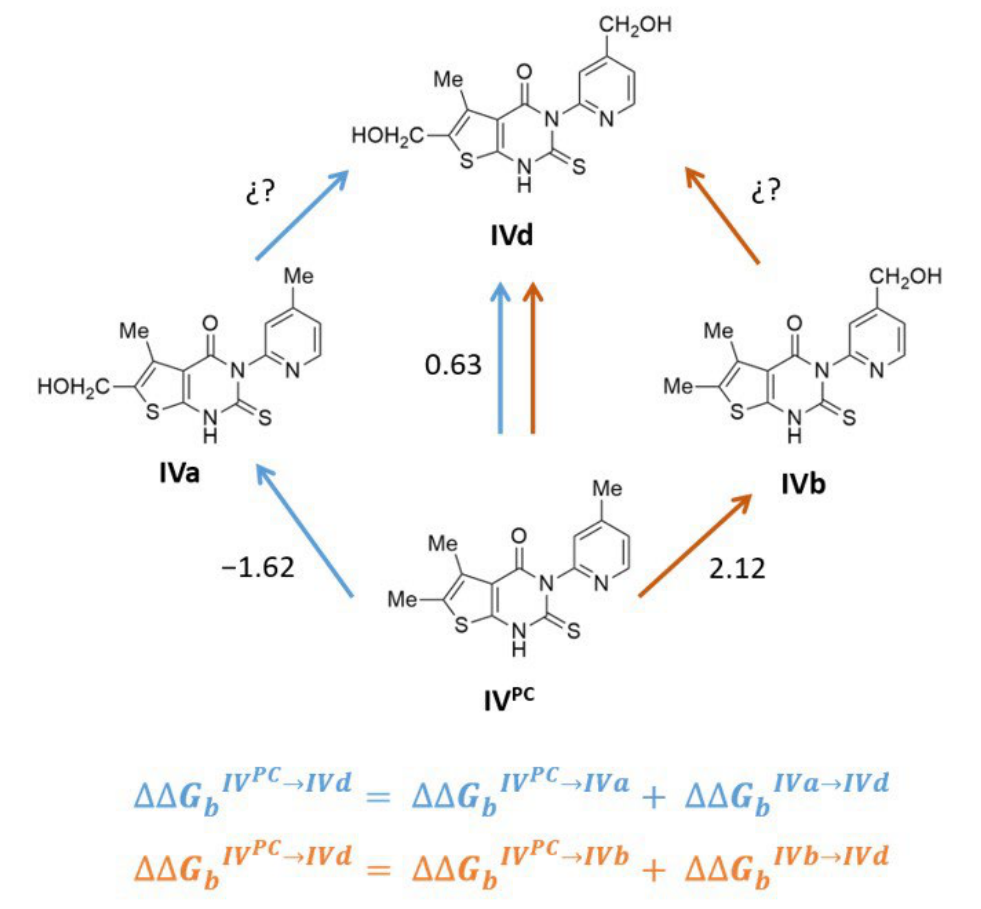
Figure 5. Direct and sequential alchemical transformations of IV PC into IVd . Computational ∆∆ G b values relative to alchemical transformations IV PC → IVa , IV PC → IVb and IV PC → IVd performed with complexes parameterized with coordinated FeII are shown near the corresponding arrows. Question marks indicate transformations for which the relative binding energies, ∆∆ G IVa → IVd ∆∆ G IVb → IVd can be arithmetically obtained from the other alchemical data shown in the figure, in addition to by performing the corresponding alchemical transformations.